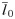
The influence of infant mortality on the relationship between l¯0 and e0 (in years) when overall mortality rates are bathtub-shaped.Shown are data points calculated from mortality trajectories where b0 = 0.0021, b1 = 0.121, and c = 0. (a) The effect of the level of senescent mortality (b0). (b) The effect of the rate of senescent mortality (b1).